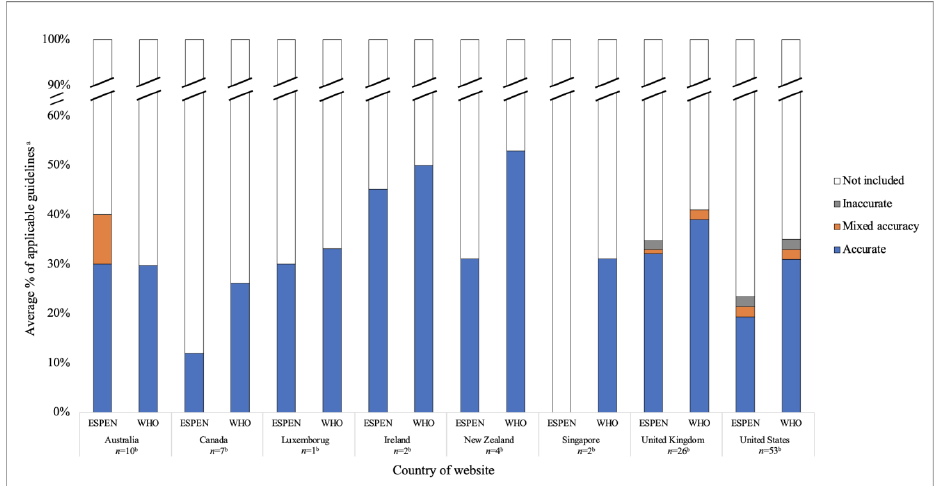
Figure 2. Accuracy of information in webpages (%) in accordance with the European Society for Clinical Nutrition and Metabolism (ESPEN) and World Health Organisation (WHO) guidelines, by country of website. Abbreviations: ESPEN, European Society for Clinical Nutrition and Metabolism; WHO, World Health Organisation. a Applicable guidelines determined by where guideline was potentially applicable as determined by context of webpage provided (prevention, treatment, or both). b n refers to the number of webpages assessed according to the ESPEN and WHO guidelines.